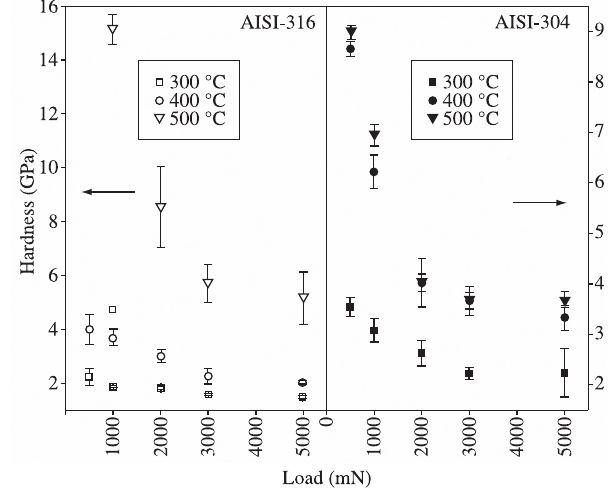
Figure 3. Instrumented indentation hardness profiles of untreated and nitrided samples at the different working temperatures.